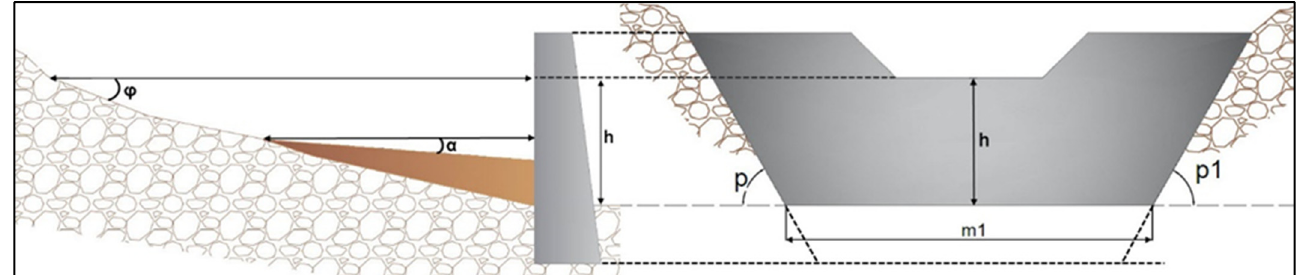
Figure 4. Check-dam cross-section side view ( left ) and front view ( right ) with the required parameters for the estimation of the effective capacity.